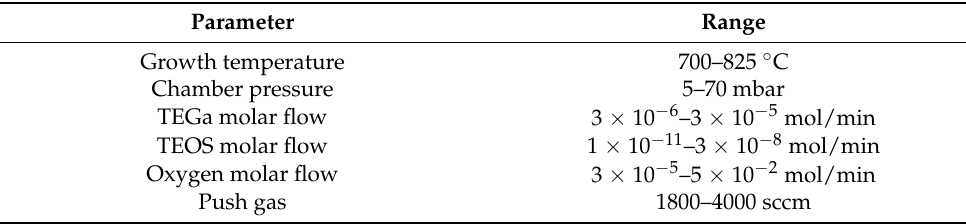
Table 1. The process parameters and their range in this work.